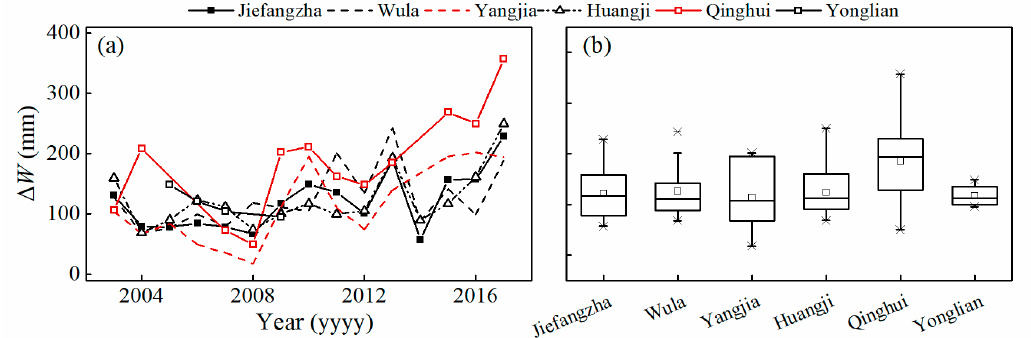
Figure 4. ( a ) The results and ( b ) the box plots of soil-ground water storage utilization ( ∆ W ) during the crop growing season in Jiefangzha and its four subareas, and Yonglian. Table 2. Statistical results of soil ‐ ground water storage utilizations and utilization efficiency of autumn irrigation of Jiefangzha and its four subareas, and Yonglian.